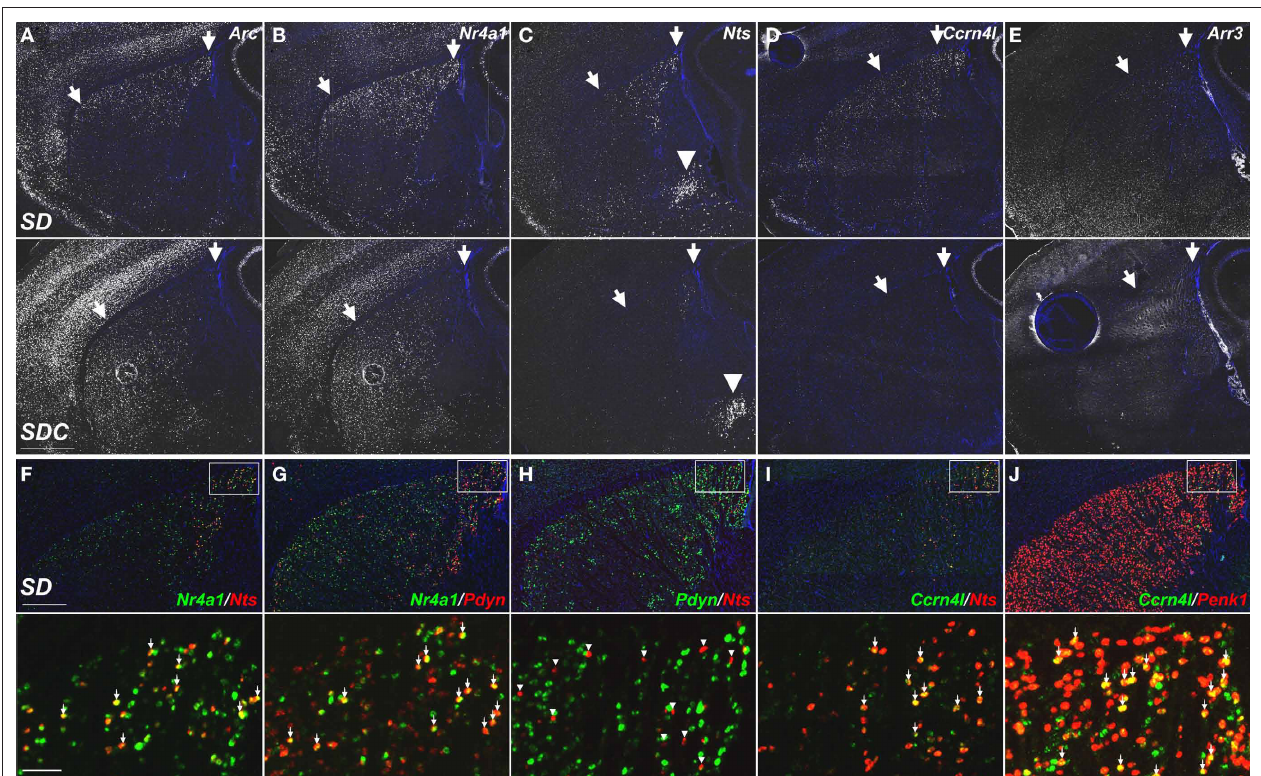
unaffected by SD. (F–J) Cellular colocalization of SD-induced mRNAs using double fluorescent ISH. Upper panels show co-labeling across the entire dorsal caudate putamen, and lower panels show a magnified view corresponding to the boxed areas. Nts extensively colocalizes with Nr4a1 (F) and Ccrn4l (i) , but does not overlap with Pdyn (H) . Arrows in (F,g,i,J) indicate cells expressing both respective gene products. Arrowheads in H indicate Nts -expressing neurons that do not co-label with Pdyn . All sections were counterstained with DAPI (blue). Scale bars: (A–e) , 1 mm; (F–J) upper panels, 500 μm; lower panels, 50